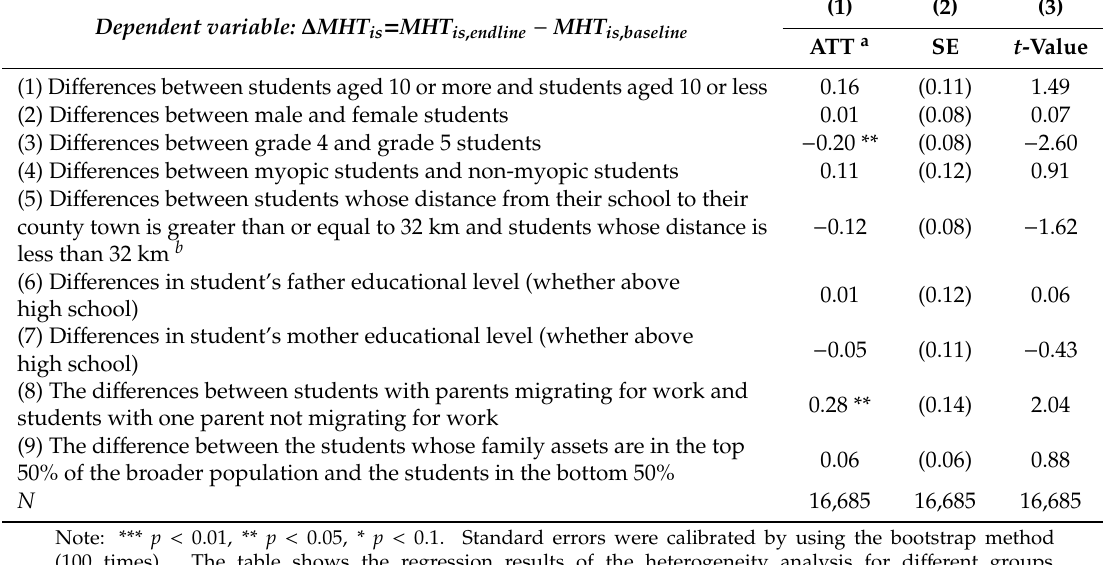
Table 6. Heterogeneity analysis of the e ff ect of boarding on students’ mental health.